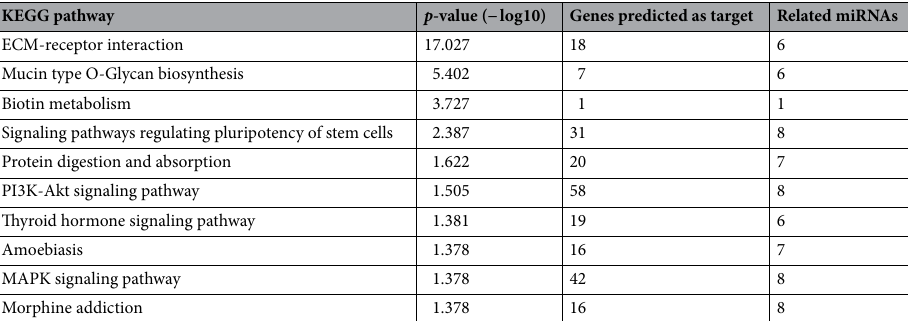
Table 3. Significant KEGG pathways potentially influenced by microRNAs in the aqueous humor of normal tension glaucoma patients. KEGG Kyoto encyclopedia of genes and genomes, NTG normal-tension glaucoma, ECM extracellular